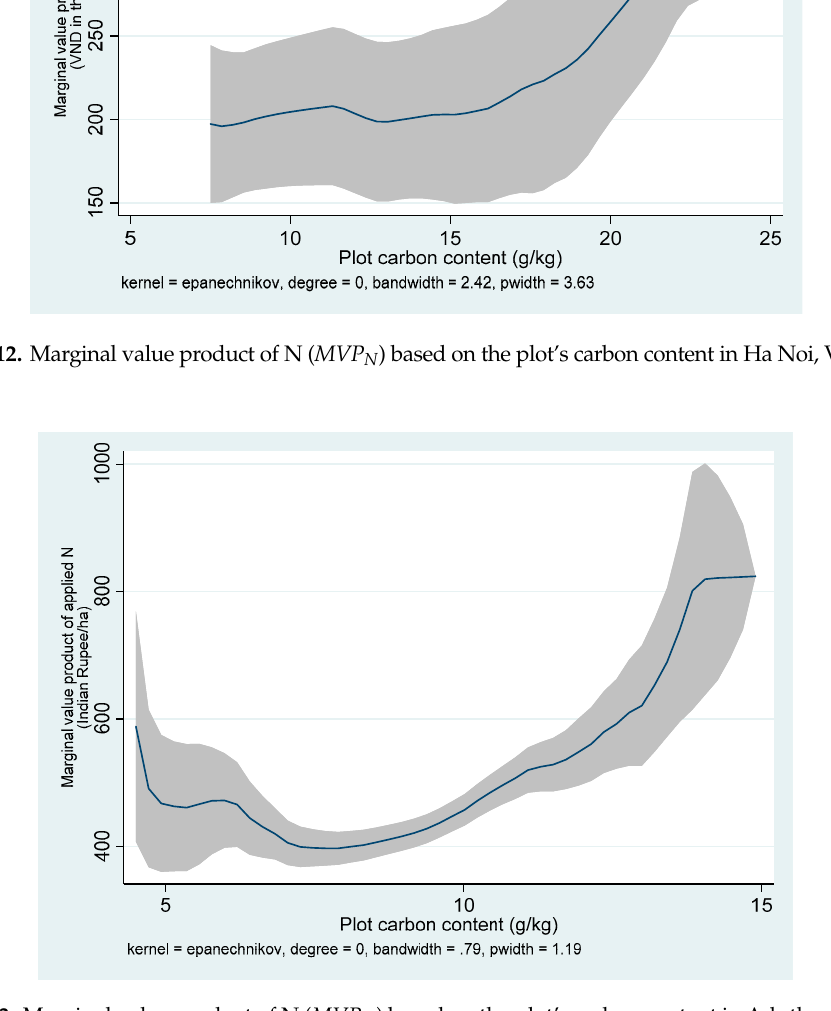
Figure 13. Marginal value product of nitrogen applied based on the plot’s carbon content in